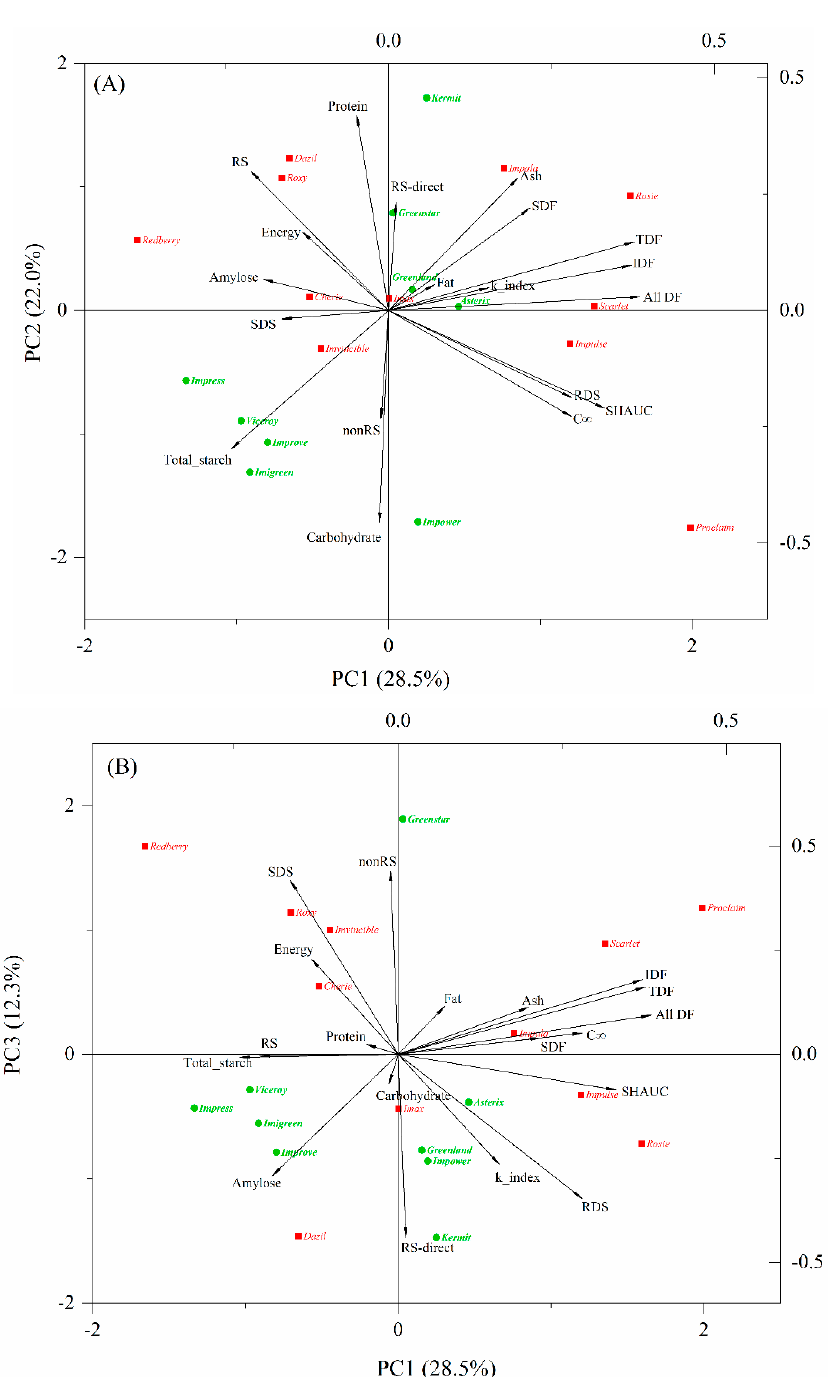
Figure 1. Biplot of the principal component analysis PC1 vs. PC2 ( A ) and PC1 vs. PC3 ( B ), describing the scores and variation in chemical and nutritional properties of cooked lentils. Abbreviations: SDF, IDF, TDF, and All_DF, soluble, insoluble, total and all dietary fibers, respectively; RDS, SDS and RS, rapidly digestible, slowly digestible and resistant starch, respectively, measured as outlined by Englyst et al.; nonRS and RS_kit, nonresistant and resistant starch, respectively, measured by Megazyme resistant starch kit; C ∞ , maximum hydrolysis extent; k _index, kinetic constant; SHAUC, the area under the in vitro starch hydrolysis curve.